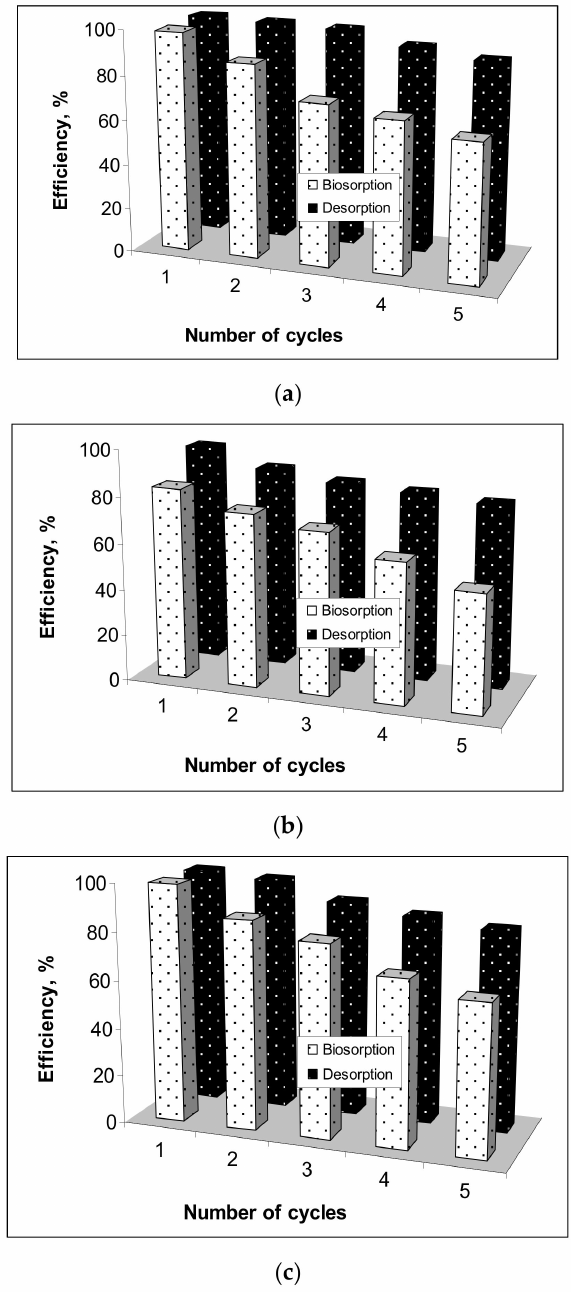
Figure 8. Efficiency of biosorption/desorption processes depending on number of cycles for ( a ) Cu(II), ( b ) Co(II) and ( c )